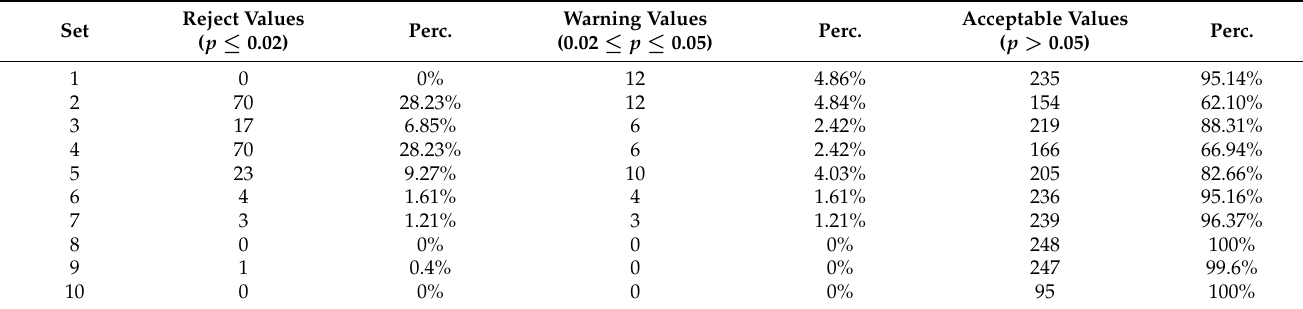
Table 5. Number of cases in which the DMA statistic test had different outcomes for the data series B ( t )